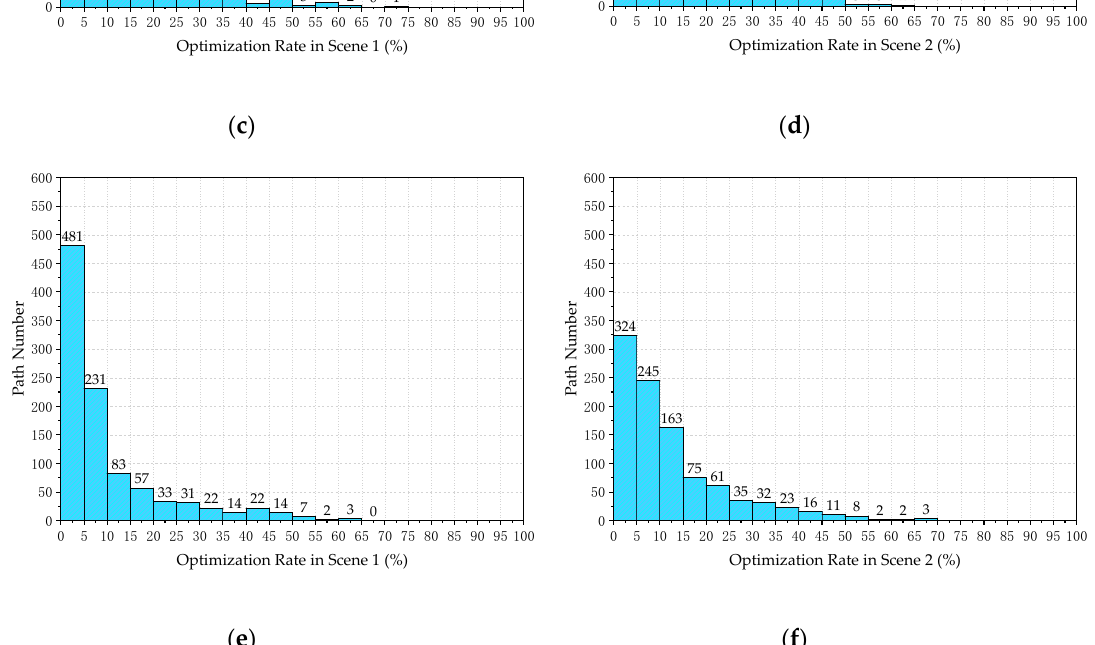
Figure 17. Optimization rate of the random path in two scenes with different terrain resolutions. ( a , c , e ) are the random tests in scene 1; ( b , d , f ) are the tests in scene 2. ( a , b ) are tested in the 0.1 m terrain resolution scenes; ( c , d ) are tested in the 0.5 m terrain resolution scenes; ( e , f ) are tested in the 1.0 m terrain resolution scenes.